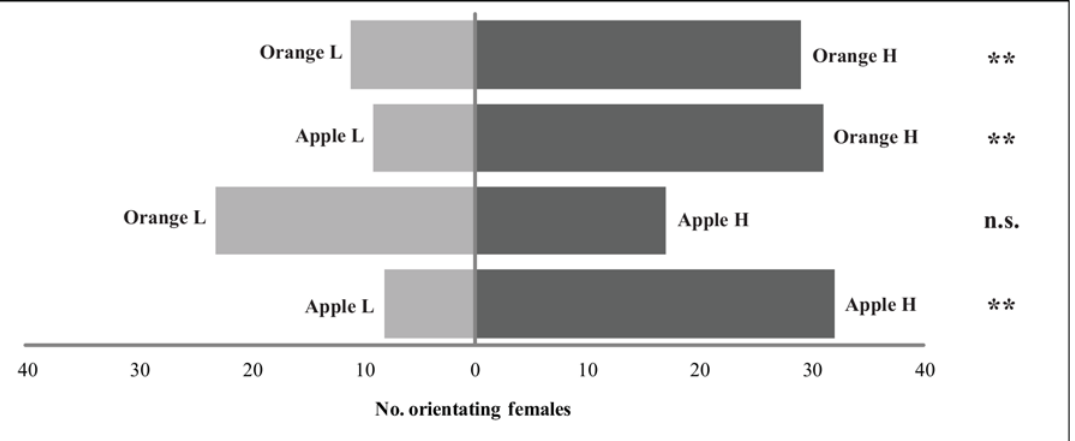
Fig 2. Preference of Diachasmimorpha longicaudata females for fruit with different levels of infestation by Ceratitis capitata . Bars show the number of females visiting each option in the experiment 2. H: high infestation level; L: low infestation level. G-test level of significance: n.s. = non-significant; * p < 0.05; ** p < 0.01.